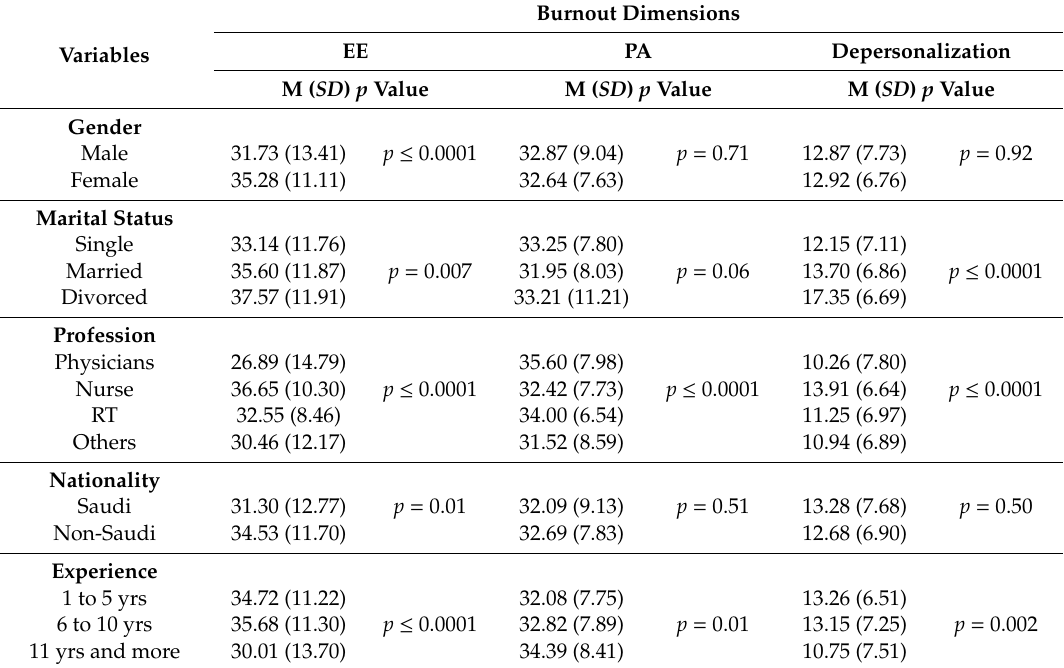
Table 4. Participants’ sociodemographic and burnout dimensions means comparisons (n =